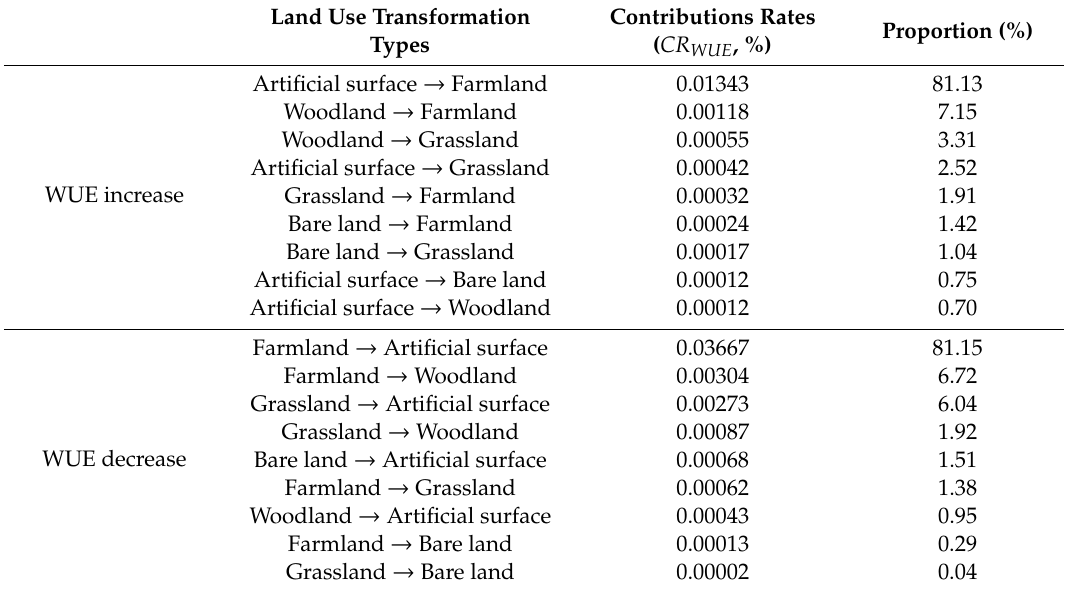
Table 3. Contribution rates of the major land use transformation types to the